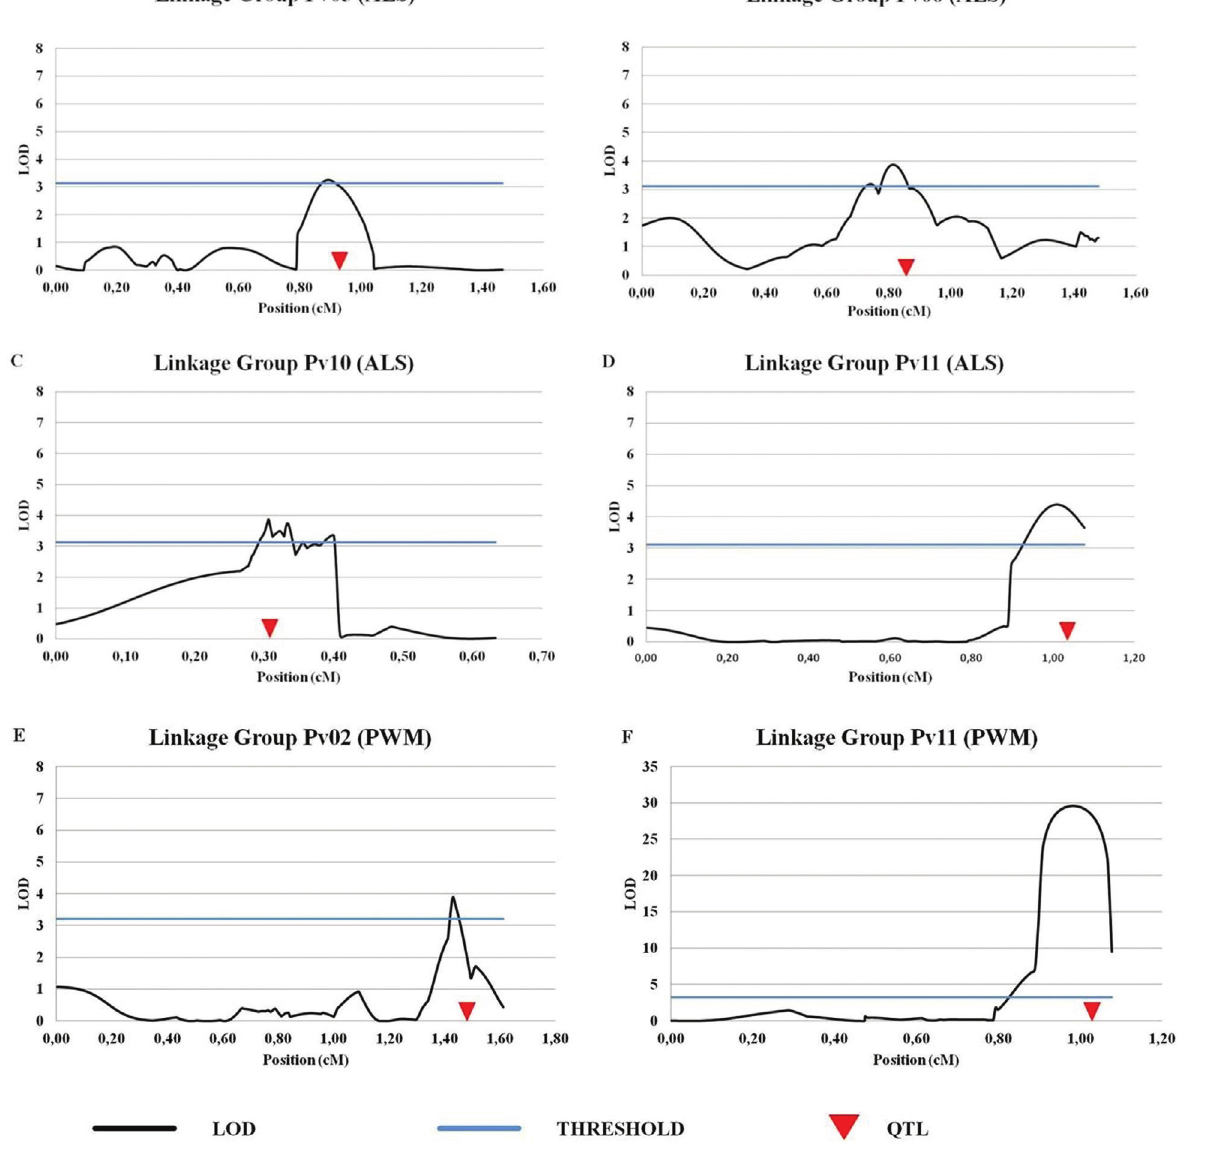
Figure2 -QTLlikelihoodplotsfoundbyCIManalysisfortheidentificationofresistanceQTLsmappedinthegeneticmapdevelopedfromtheAND277 x SEA 5(AS) population. QTLs associated to angular leaf spot (ALS) were referred as A to D and QTLs associated to powdery mildew (PWM) were re- ferred as E and